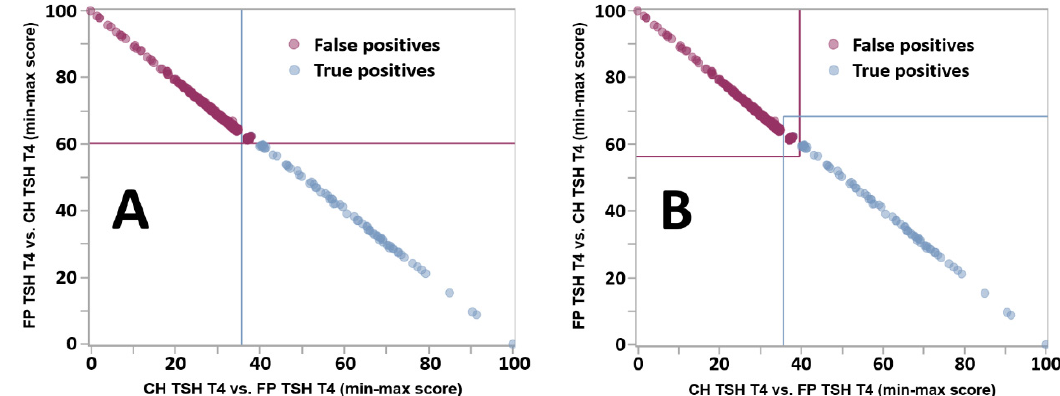
Figure 4. Improved definition of indeterminate cases by the Dual Scatter Plot. Legend: Dual Scatter Plot customized for location Georgia applied to the differential diagnosis between CH with high TSH and low T4 (CH TSH T4) and false positive cases with the same phenotype (FP TSH T4). The total counts of cases for true positive and false positive cases were 117 and 1360, respectively. The count of Indeterminate cases was 900, 46 (39%) true positives and 854 (63%) false positives. (Panel A ): original design. Each plot is divided in four quadrants: Lower right: consistent with CH TSH T4 (light blue circles); Upper right: indeterminate (both conditions are possible); Upper left: consistent with FP TSH T4 (purple circles); Lower left: neither condition. (Panel B ): new design. See text for a description of the line drawing.